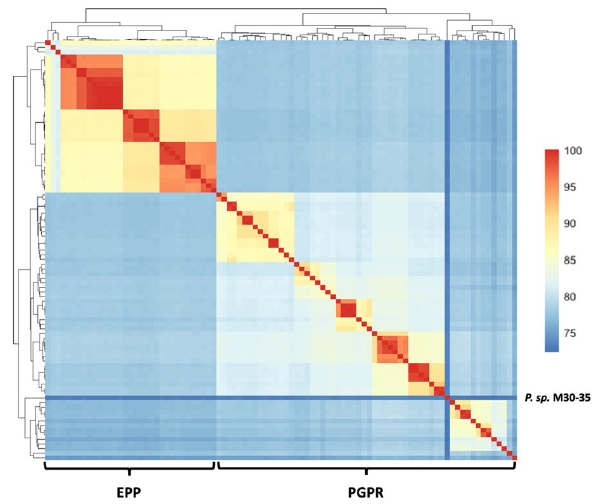
Figure 2. Pairwise Average Nucleotide Identity (ANI) scores between coding regions. Scores were calculated from alignments that have 70% or more identity and at least 70% coverage of the shorter gene.